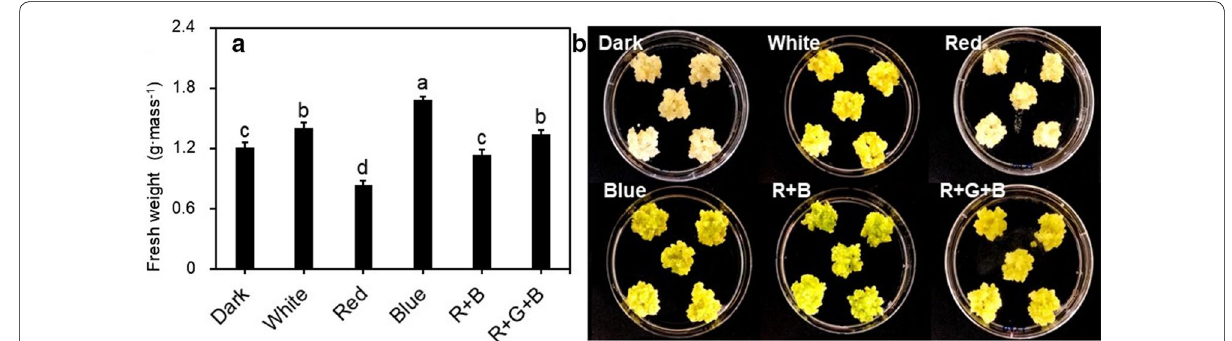
Fig. 2 Effect of light quality on the fresh weight of transgenic callus. a Fresh weight of callus cultured under different light quality; b callus growth after 4 weeks of culture. Data represent mean multiple range